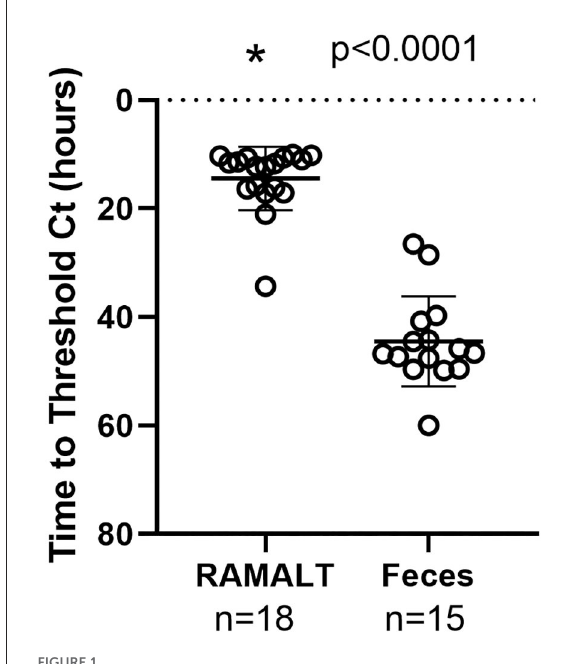
FIGURE1 RT-QuIC testing of white-tailed deer RAMALT and feces and time to threshold (Ct) relationship. RAMALT ( n = 18) has a significantly lower Ct value compared to fecal samples ( n = 15) ( p < 0.0001). The * symbol indicates Ct value.